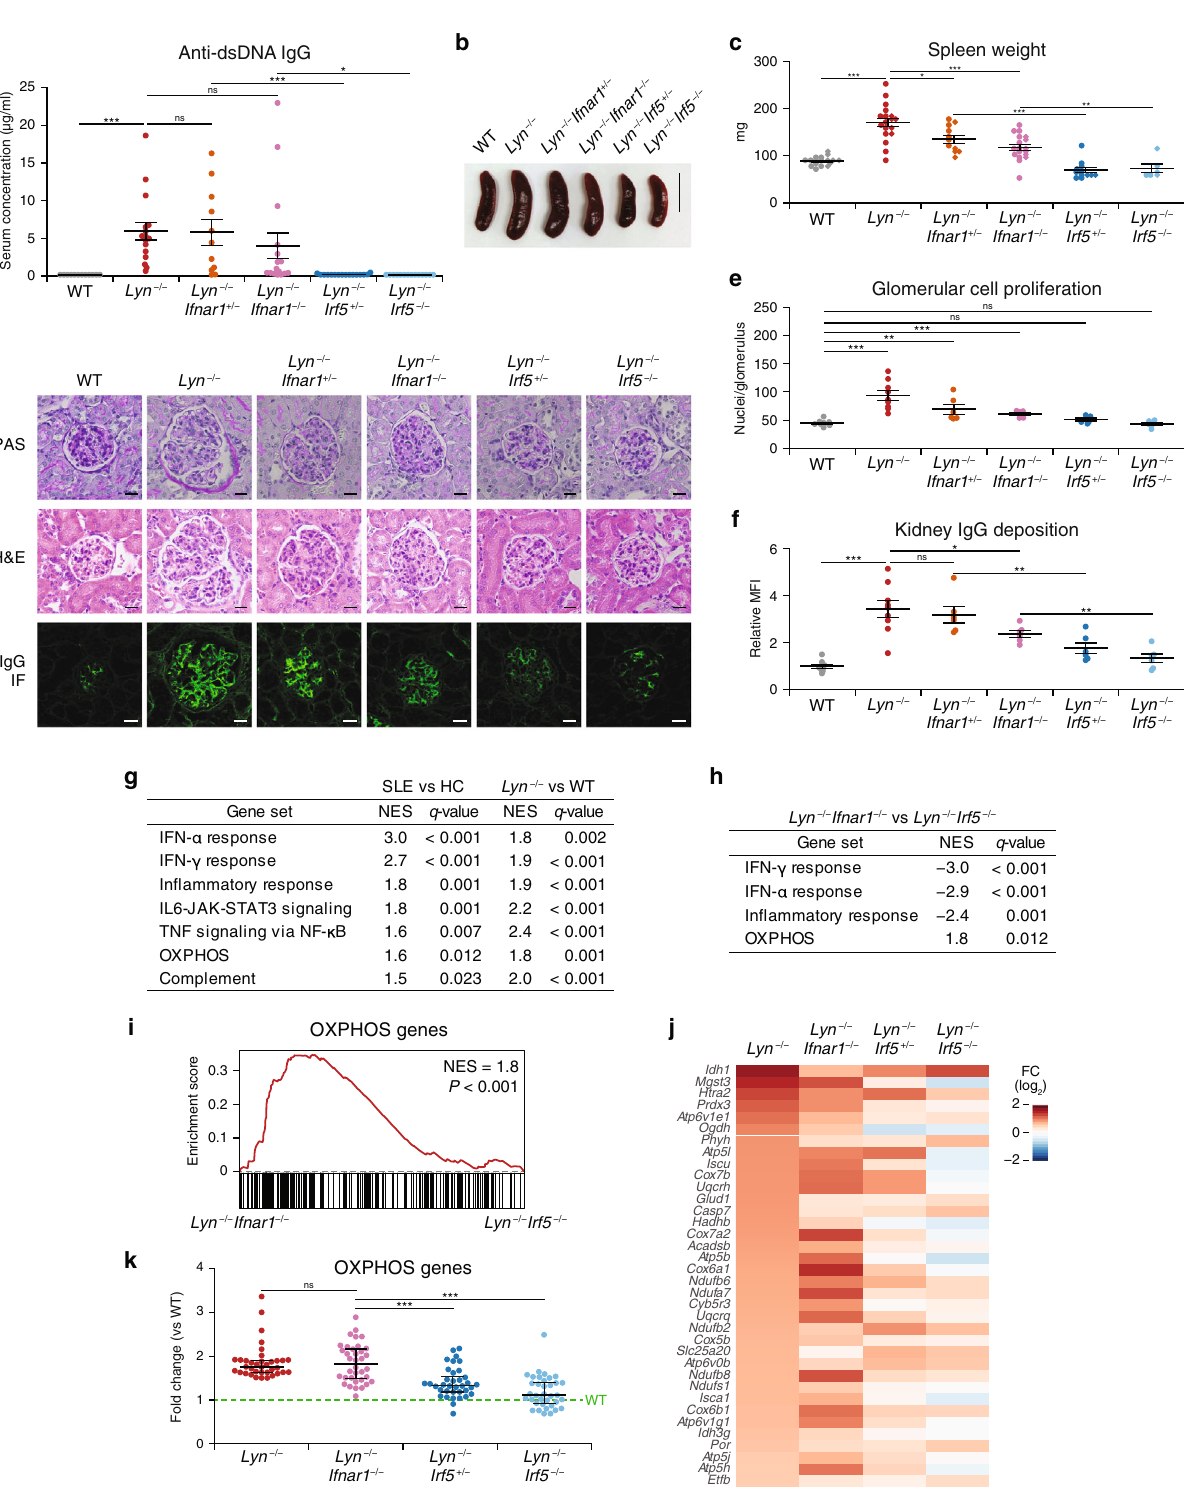
immune cells, particularly, the expression of CD80 and CD69 on cDC2s and CD4 + T cells, respectively (Supplementary Figs. 5a, b and 6a, b). Our results are in agreement with the fi ndings obtained in Fc γ RIIB − / − Yaa and Fc γ RIIB − / − mouse models of SLE 27 . These results suggested that even partial inhibition of IRF5 is superior to the full inhibition of type I IFN signaling in terms of suppressing the development of an SLE-like disease.